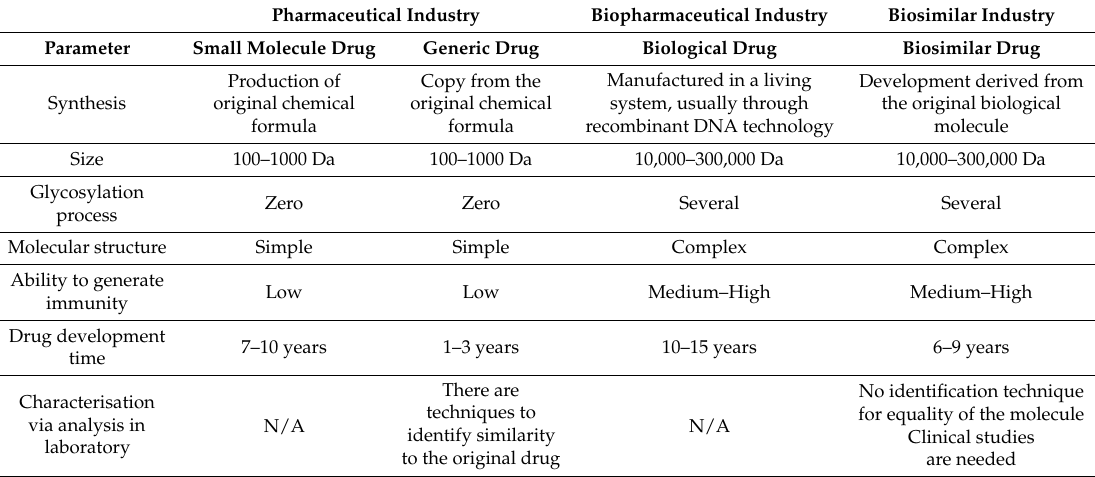
Table A5. Differences between small molecule, generic, biological and biosimilar